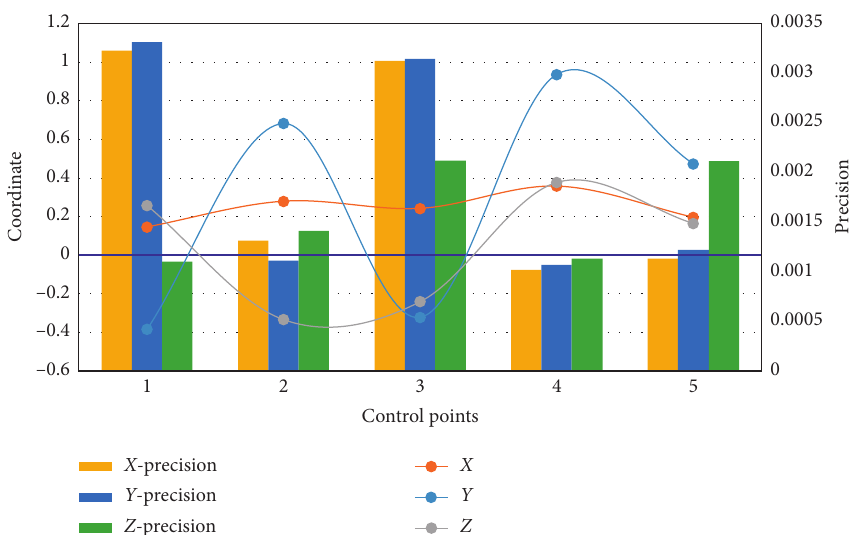
Figure 1: Measuring point coordinates and accuracy statistics.